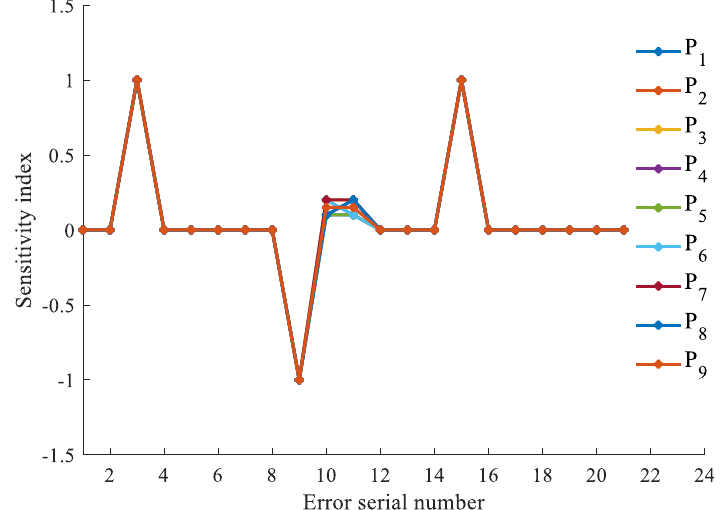
Figure 5. Sensitivity index of position error in the z direction.